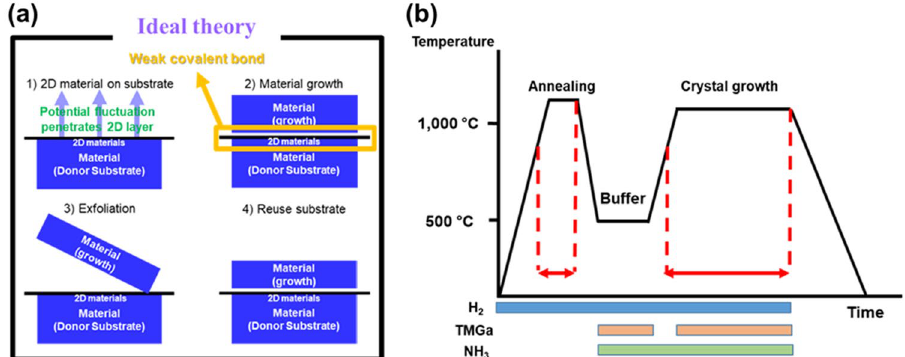
Fig. 7 a Illustration of ideal theory of III‑nitride growth on 2D layer. The weak covalent bond caused by an interfacial 2D layer between overgrown layer and the substrate allows the exfoliation of overgrown layer. Subsequently, a used substrate can be recycled for saving a cost. b Typical two‑step GaN growth condition on c‑plane sapphire substrate for high crystal quality GaN using MOCVD. This reveals that III‑nitride growth conditions such as high temperature, and toxic gases (H 2 and NH 3 ) may change the properties of 2D